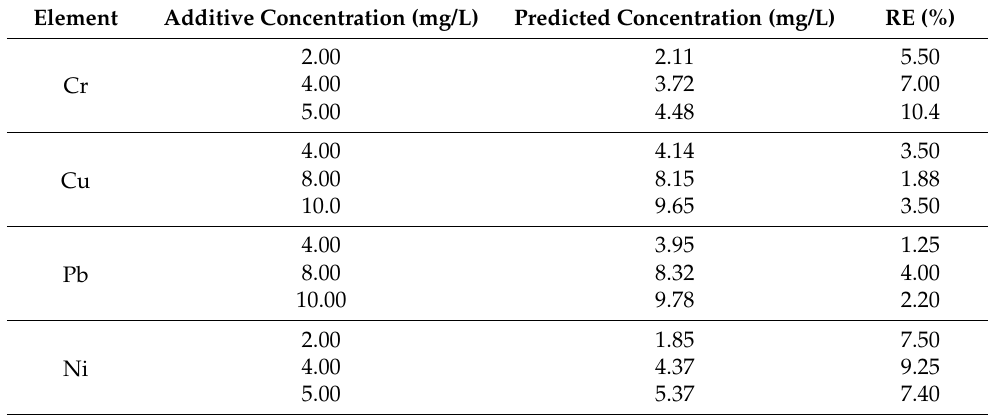
Table 2. Accuracy of